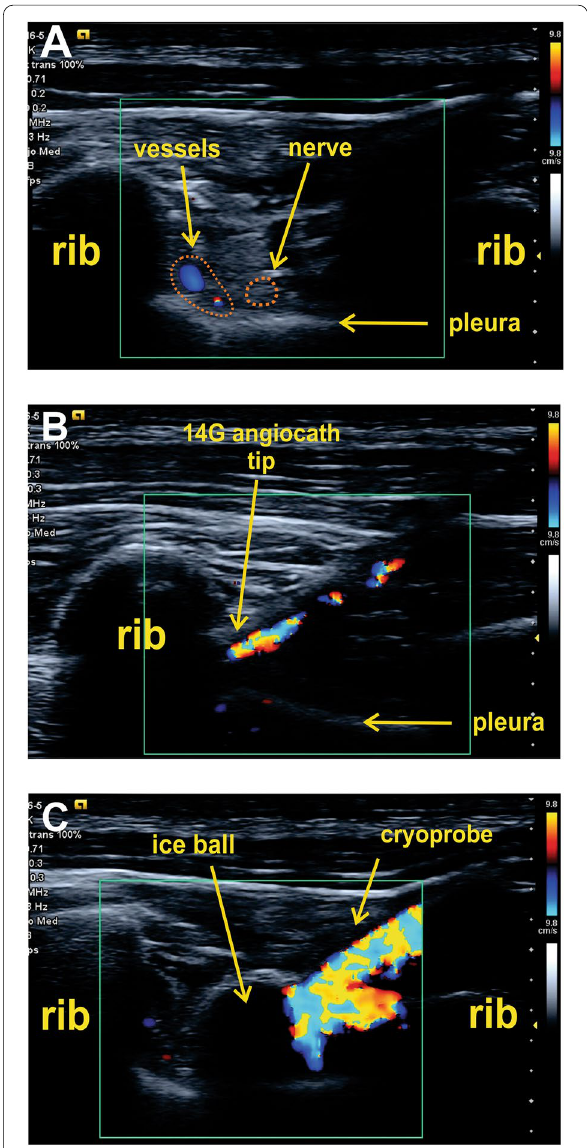
Fig. 3 US-guided percutaneous cryoanalgesia sequence. A In gray scale images, US contrast is adjusted to magnify anatomical landmarks and the cryoprobe. Then, color Doppler detects the intercostal neurovascular bundle. B 14G angiocath is not clearly defined and the twinkling artifacts show that the angiocath tip is placed deep inside the intercostal space beyond the intercostal nerve. C Angiocath is then retired a few millimeters until the tip is placed above the nerve. The ice ball is visualized above the intercostal nerve and the cryoprobe contour is highlighted by the twinkling